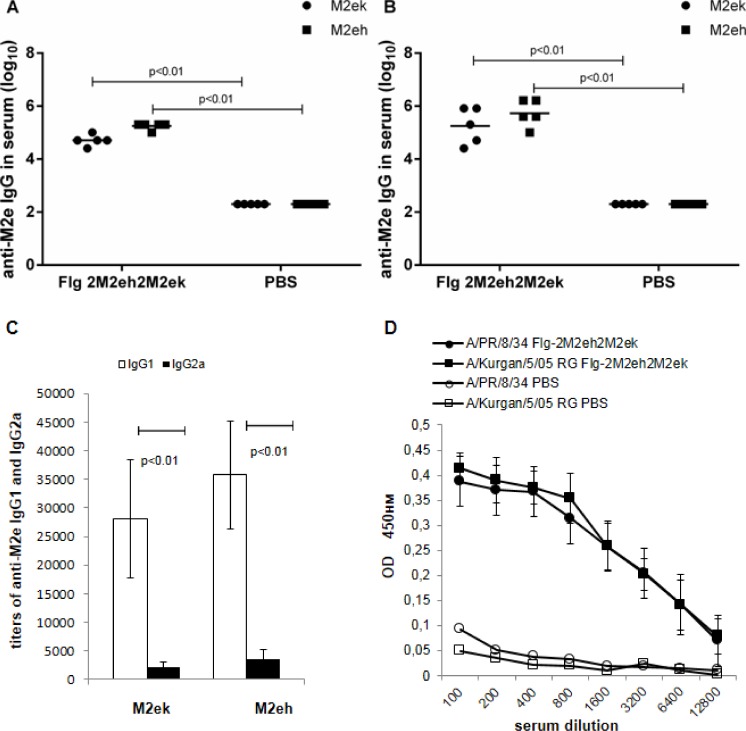
Anti-M2e antibody response in serum.BALB/c mice (n = 5/group) were immunised i.n. with 50 μg of Flg-2M2eh2M2ek recombinant protein on days 0, 14, 28. Mice of control group were administered with PBS. Two weeks post-first (A) and second boosts (B) M2e-specific IgG responses were evaluated by ELISA to M2eh and M2ek synthetic peptides. Horizontal bars indicate mean titres among 5 mice per group. (C) Anti-M2e IgG subclasses tested against M2ek and M2eh in serum 2 weeks post-second boost were determined by ELISA. Statistically significant differences between IgG1 and IgG2a levels: p<0.01. Statistical significance was determined using Mann-Whitney U-test. The P values between immunised and control group are indicated. (D) Recognition of influenza-infected MDCK cells by antisera from Flg-2M2eh2M2ek immunised mice. PBS line refers to control mice group, immunised i.n. with PBS. Two weeks post-second boost sera were tested for reactivity with non-infected and infected with A/PR/8/34 (H1N1) and A/Chicken/Kurgan/05/05 RG (H5N1) MDCK cells in vitro. Data represent the ΔOD450 (infected—uninfected cells).